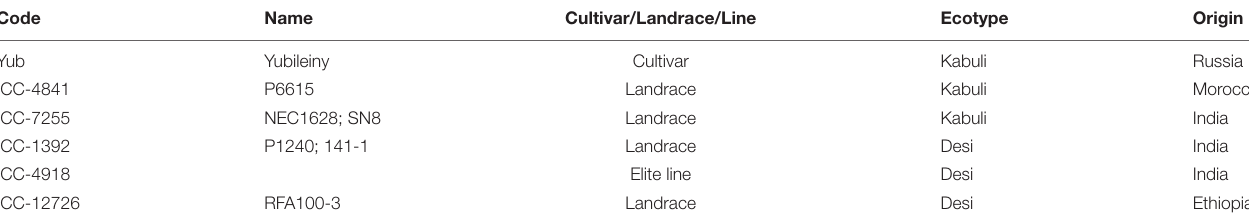
TABLE 1 | List and short description of six selected chickpea germplasm accessions used for molecular analyses.